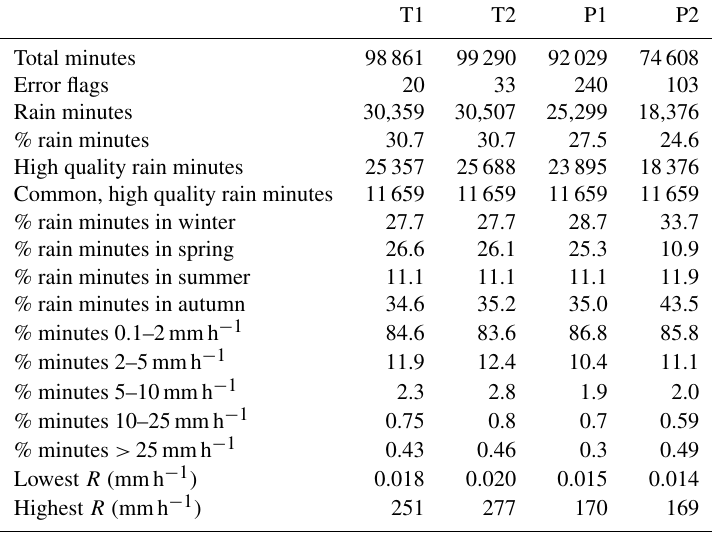
Table 3. Disdrometer data summary. Number of minutes recorded, errors, minutes with rain (SYNOP codes 61, 63 and 65), and high quality minutes; percentage of records in each season, and by rain intensity ranges; and maximum rain intensity. T1 T2